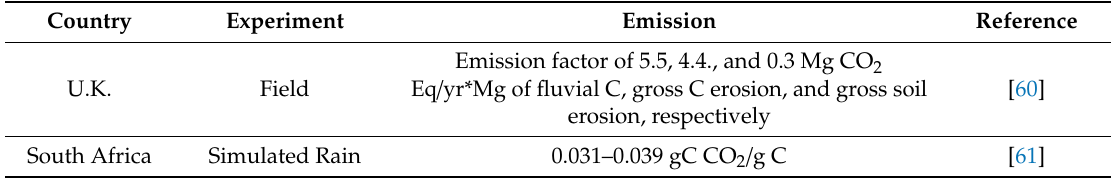
Table 5. Examples of gaseous emission from eroded sediments and disrupted / broken aggregates by erosional